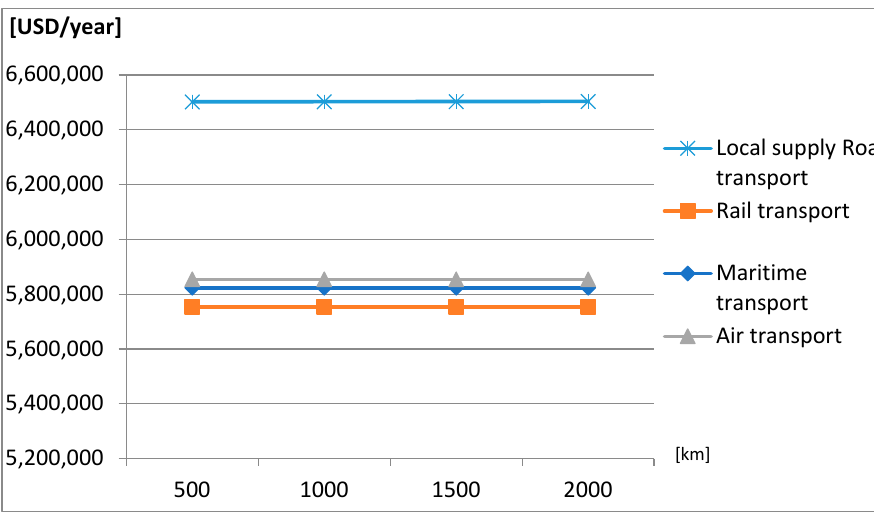
Figure 3. Results of simulations—impact on total costs (electronic higher value).